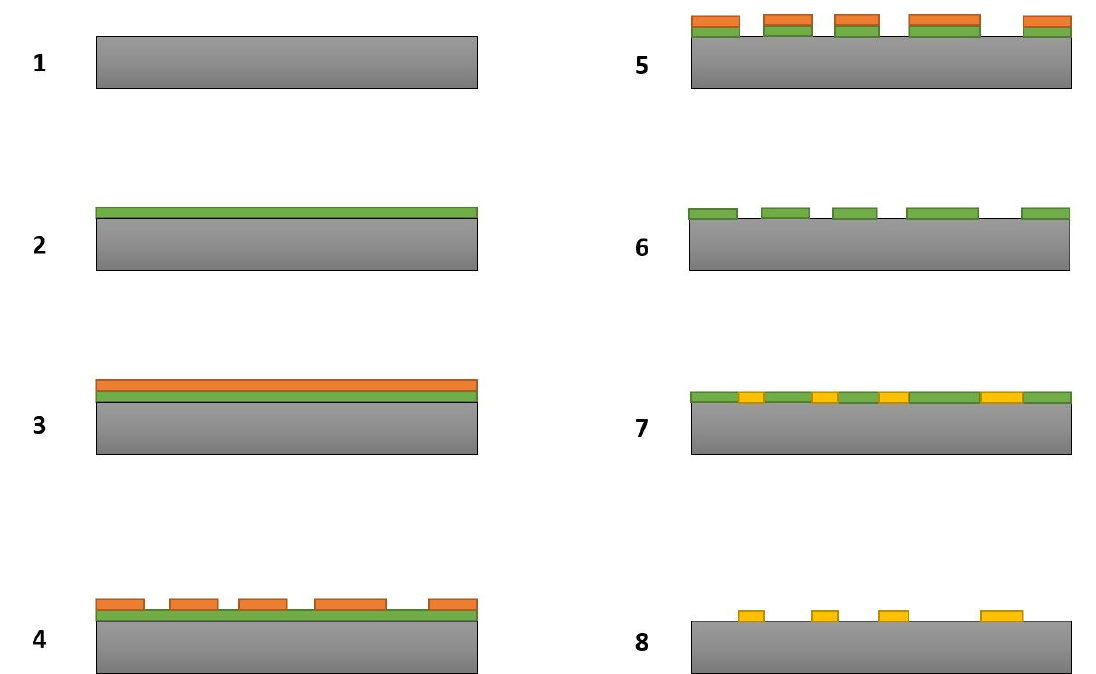
Figure 1. Steps involved in the fabrication of B-C microstructures: ( 1 ) Silicon substrate, ( 2 ) Sputter deposition of tungsten mask, ( 3 ) Application of photoresist, ( 4 ) Transfer of pattern onto photoresist, ( 5 ) Etching of selective areas of tungsten mask, ( 6 ) Removal of residual photoresist, ( 7 ) Chemical vapor deposition (CVD) of B-C compound in selective areas, ( 8 ) Etching of remaining tungsten mask to obtain B-C microstructures.